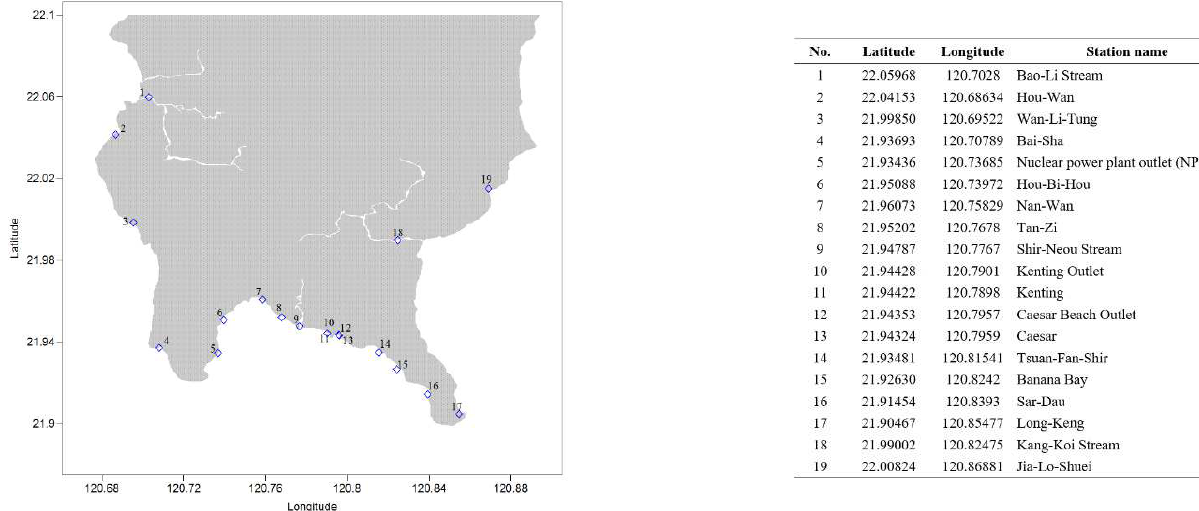
Figure 1. Map of study site and appended table with GPS coordinates.